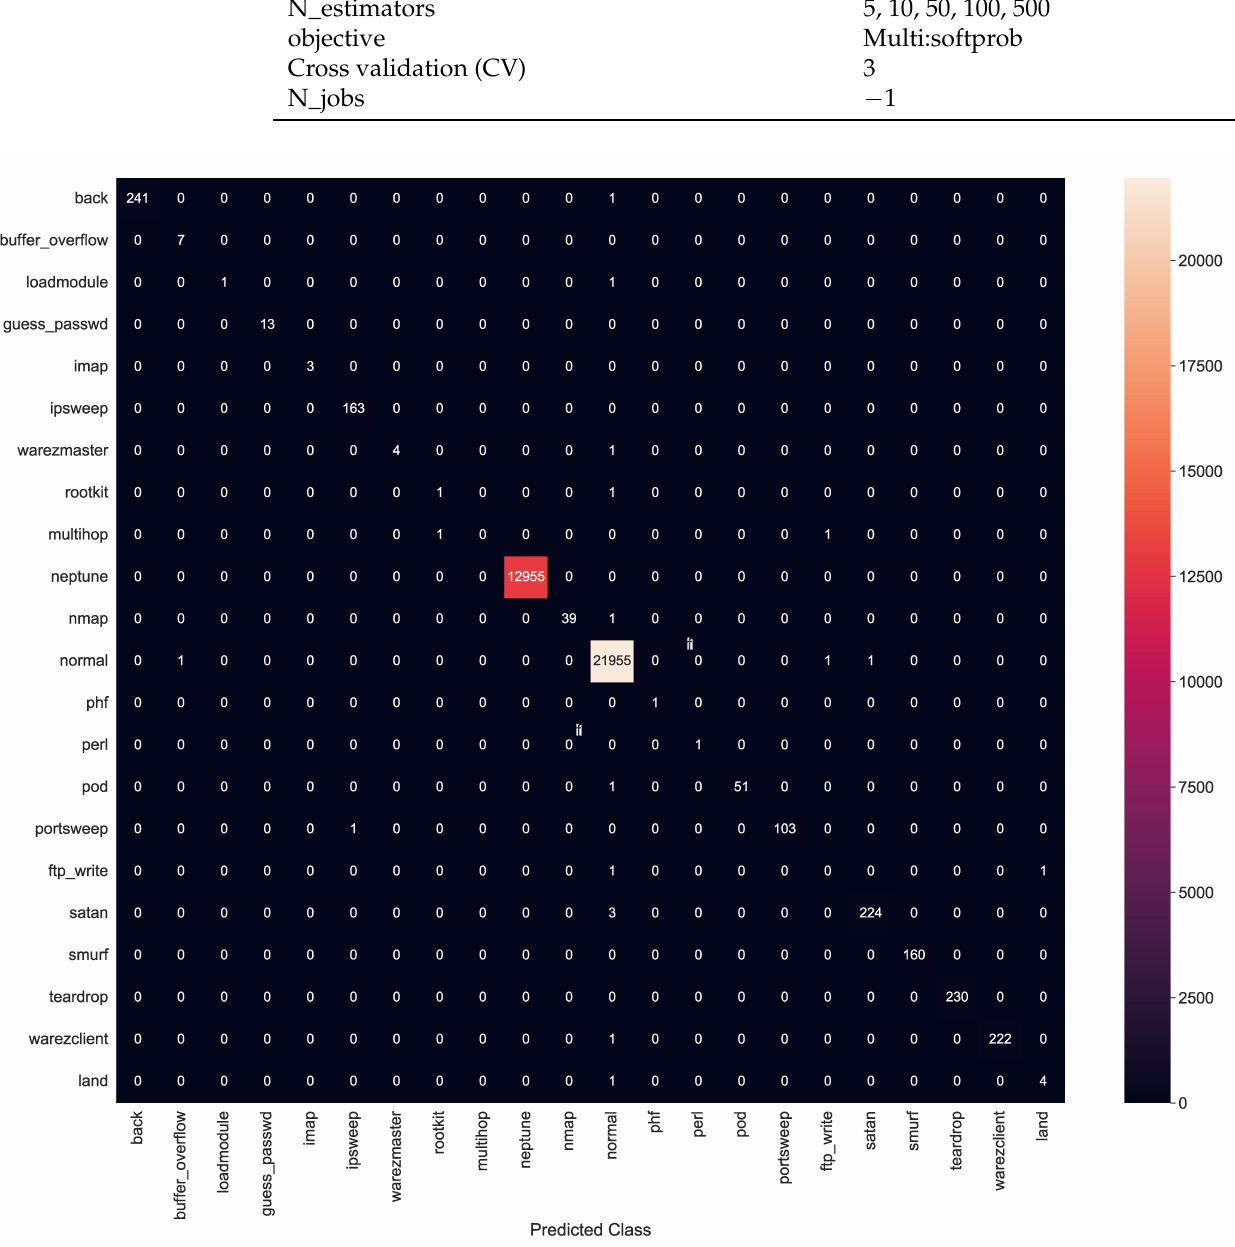
Figure 16. Confusion matrix for